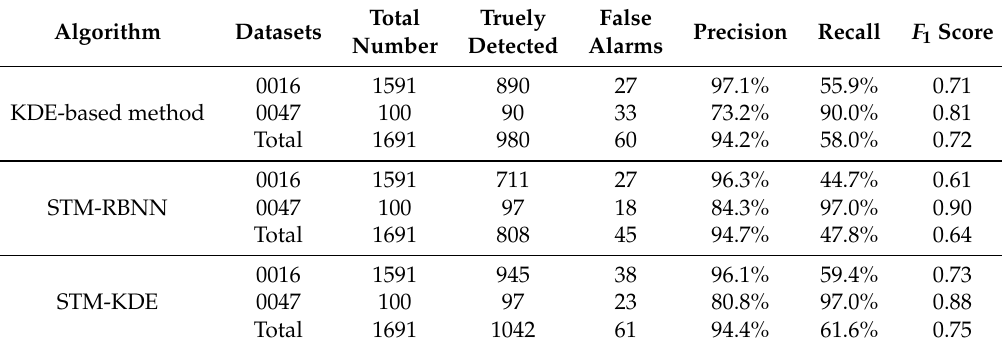
Table 2. Pedestrian detection in the range of 25 m.